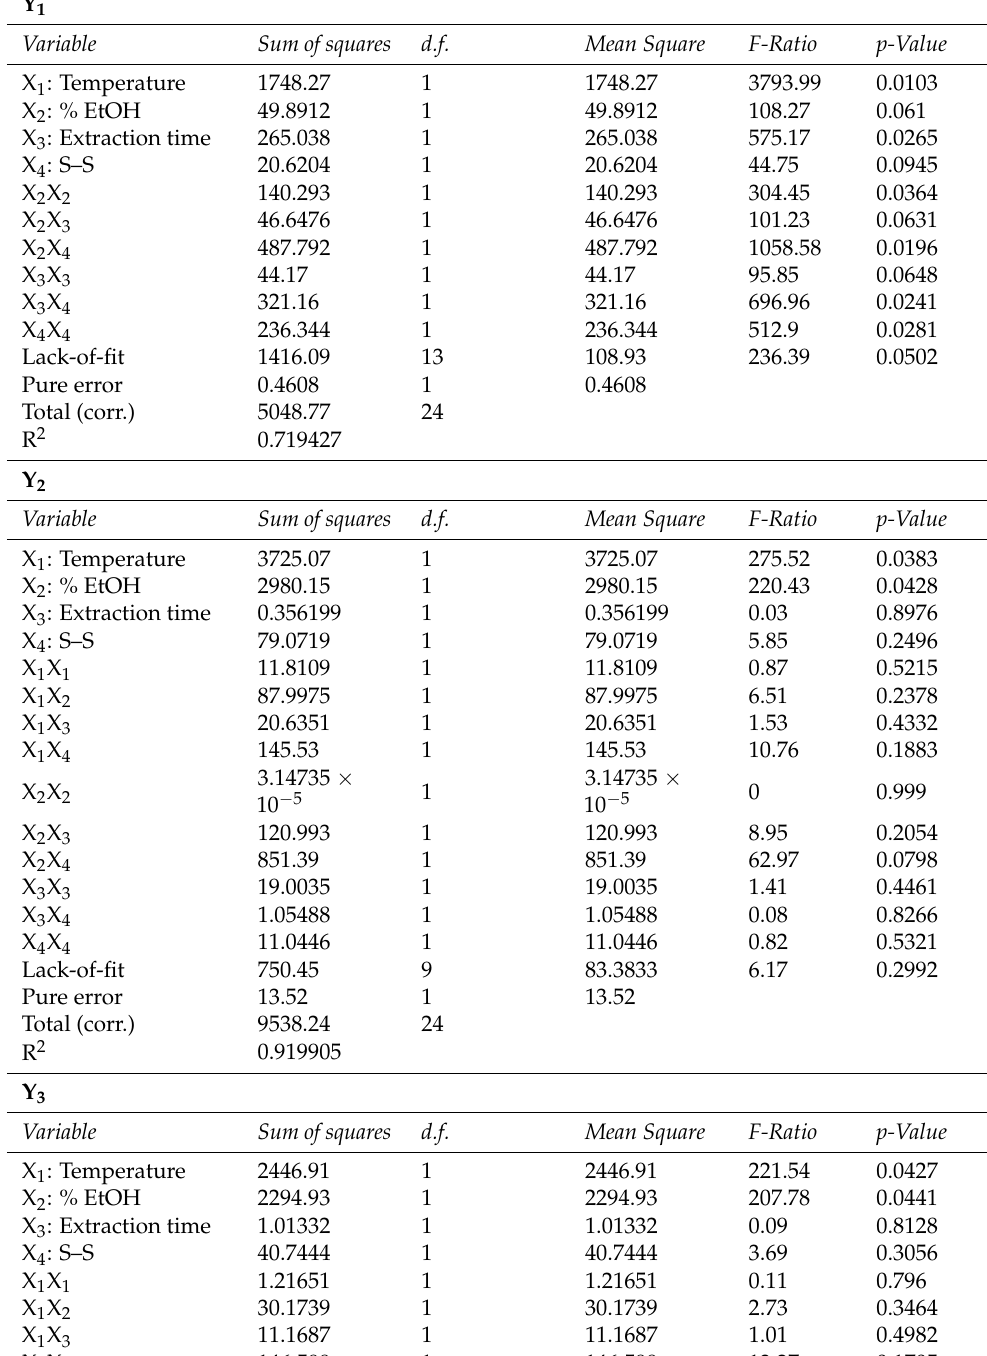
Table 2. Analysis of Variance (ANOVA) of the proposed regression